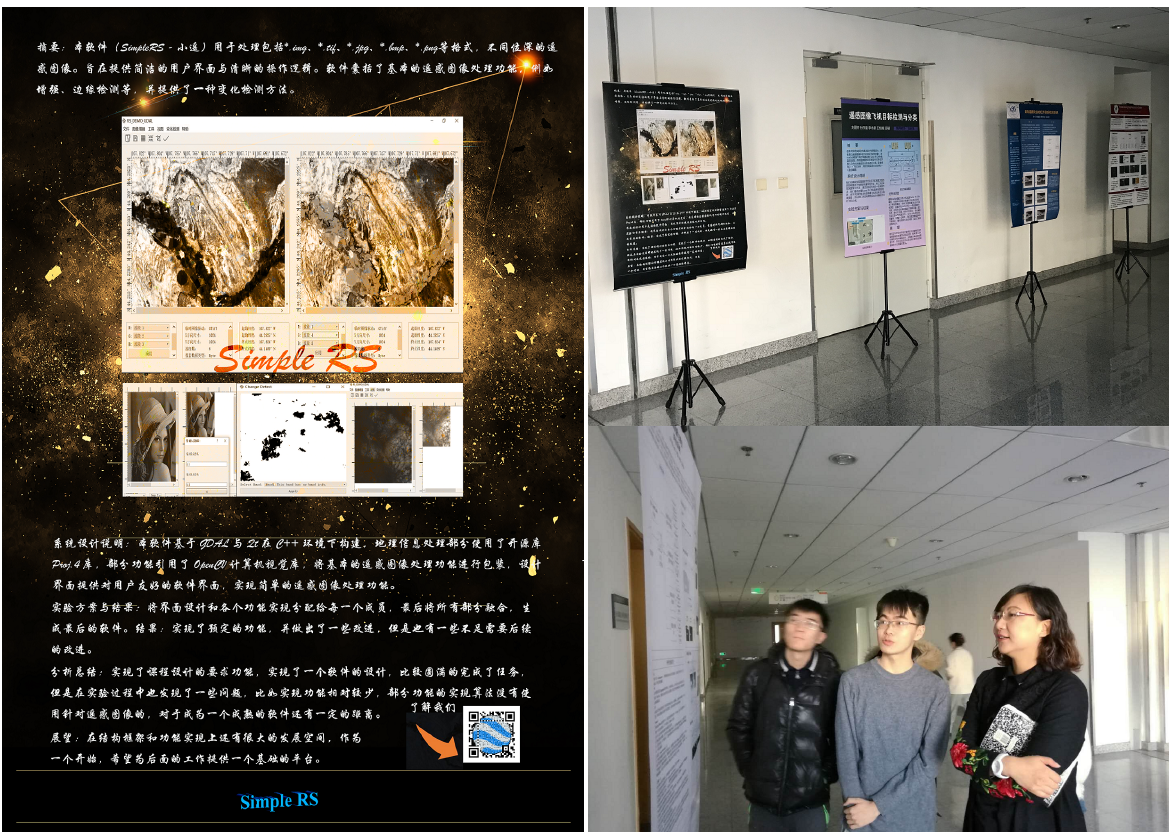
Figure 2. Poster presentation in